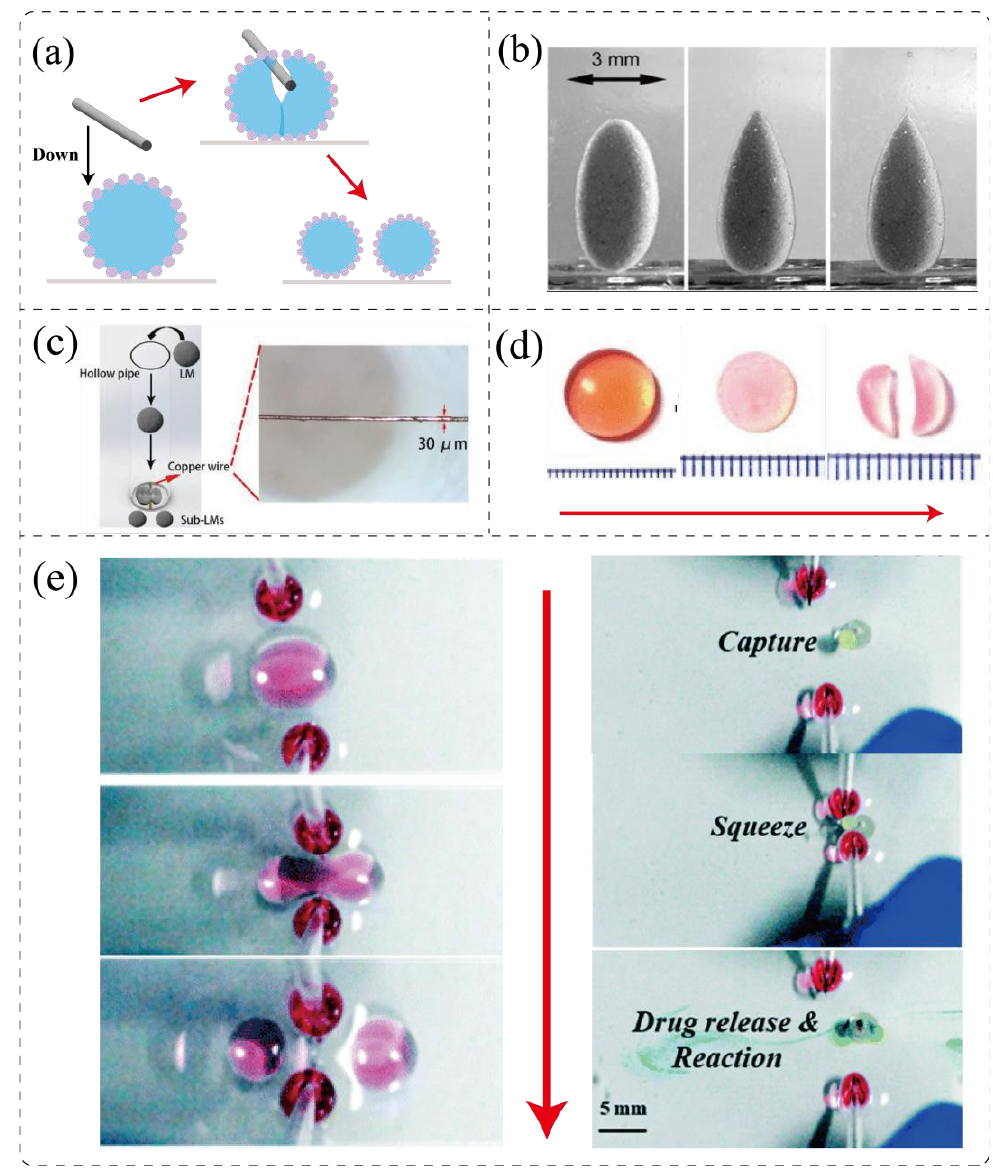
Figure 16. ( a ) Division of a water marble by a solid rod [70]. ( b ) Lycopodium-coated marble deformed in an electrostatic field to a Taylor cone and the related jetting [97] (Reproduced with permission from Springer Nature, 2013). ( c ) An LM is split into two daughter LMs, caused by a copper wire during the fall process [144] (Reproduced with permission from John Wiley and Sons, 2019). ( d ) An LM is cut into two portions that are not like the traditional spherical cap [145] (Reproduced with permission from Springer Nature, 2016). ( e ) The droplet splitting, accurate transport and release on demand of LMs, under the decanol liquid lenses action [146] (Reproduced with permission from Royal Society of Chemistry, 2022).